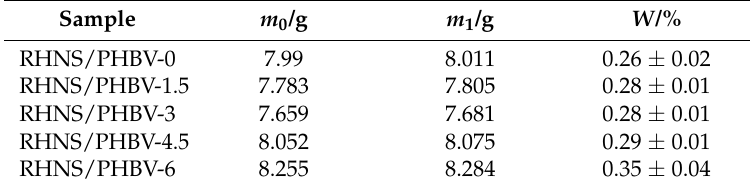
Table 1. Water absorption properties of RHNS/PHBV composites with different content of RHNS.